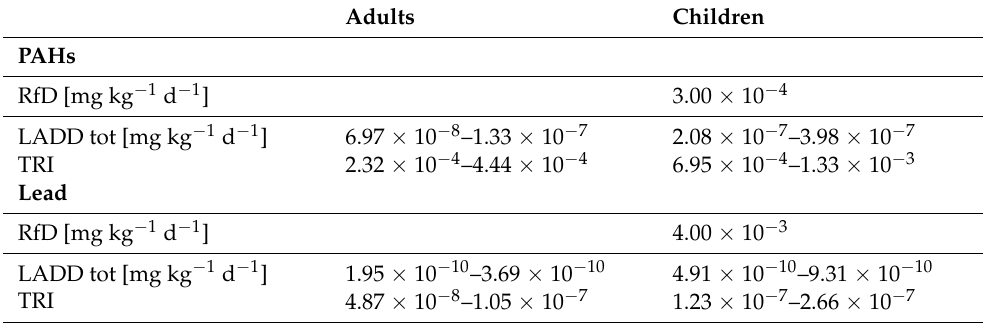
Table 7. Toxic risk for PAHs and Lead from ingestion, with particulate soot emissions in the range of 8–15 mg/m 3 daily